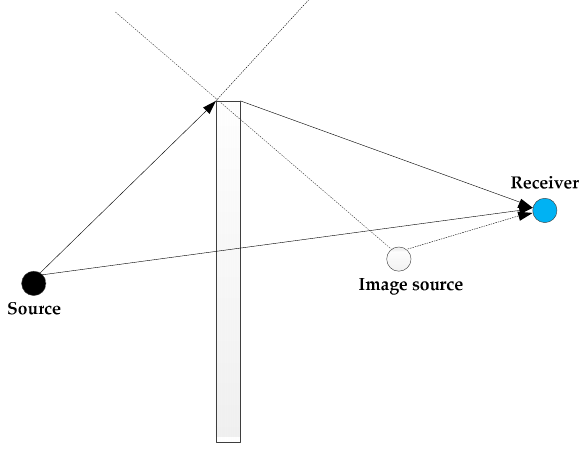
Figure 5. Diffraction of sound by a thin barrier.